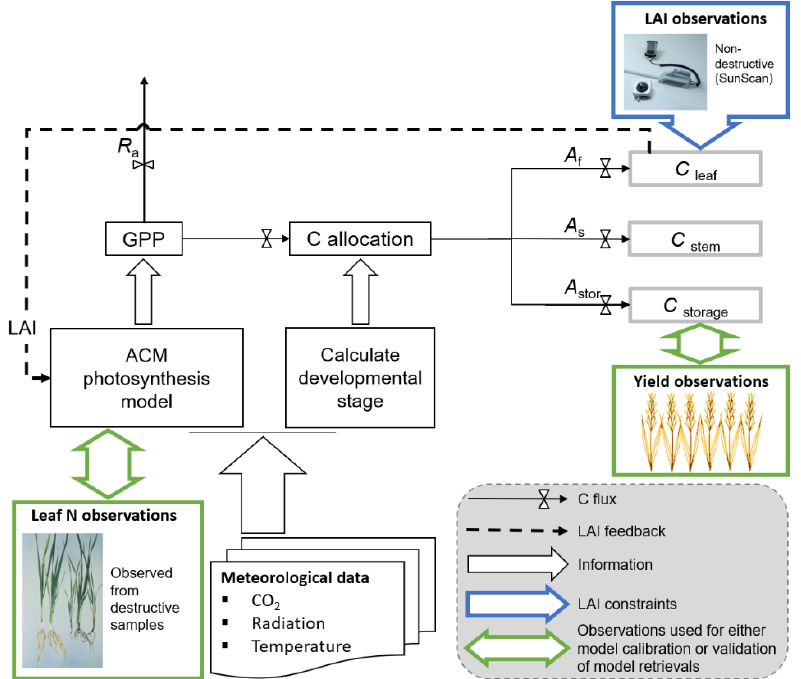
Figure 2. DALEC-Crop model structure relevant to canopy development and yield. Daily estimates of gross primary productivity (GPP) are determined by the Aggregated Canopy Model (ACM)— a function combining inputs of leaf area index (LAI), climate and leaf nitrogen (N). Where leaf N can be provided based on destructive samples or can be inferred based on LAI observations. After a fractional loss of carbon (C) through autotrophic respiration (Ra), remaining C allocation is applied as a function of crop developmental stage—calculated from daily accumulations of effective temperature, photoperiod and vernalization (until emergence). According to the calculated allocation (A) fraction, C is allocated to C pools (including leaf, stem, and storage). Allocated C is lost from the pools either through harvest exports or root litter. DALEC-Crop parameters are calibrated based on the comparison between modelled and observed leaf area index (LAI) values.